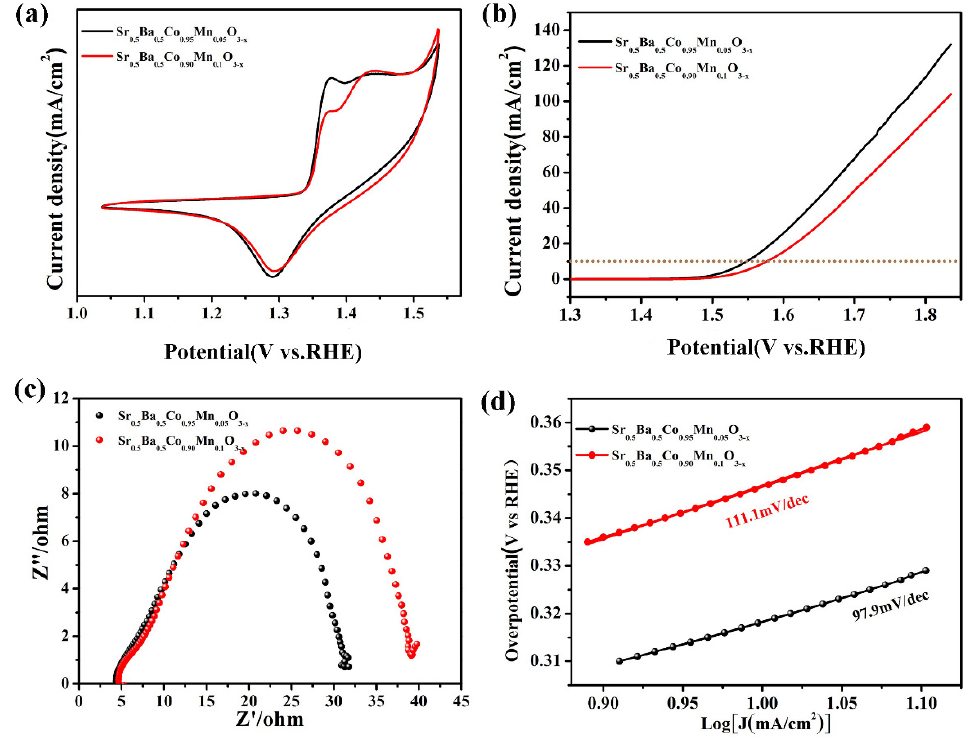
Figure 7. OER test curves of Sr 0.5 Ba 0.5 Co b Mn 1 − b O 3 − x ( a ) CV, ( b ) LSV, ( c ) EIS, ( d ) Tafel.